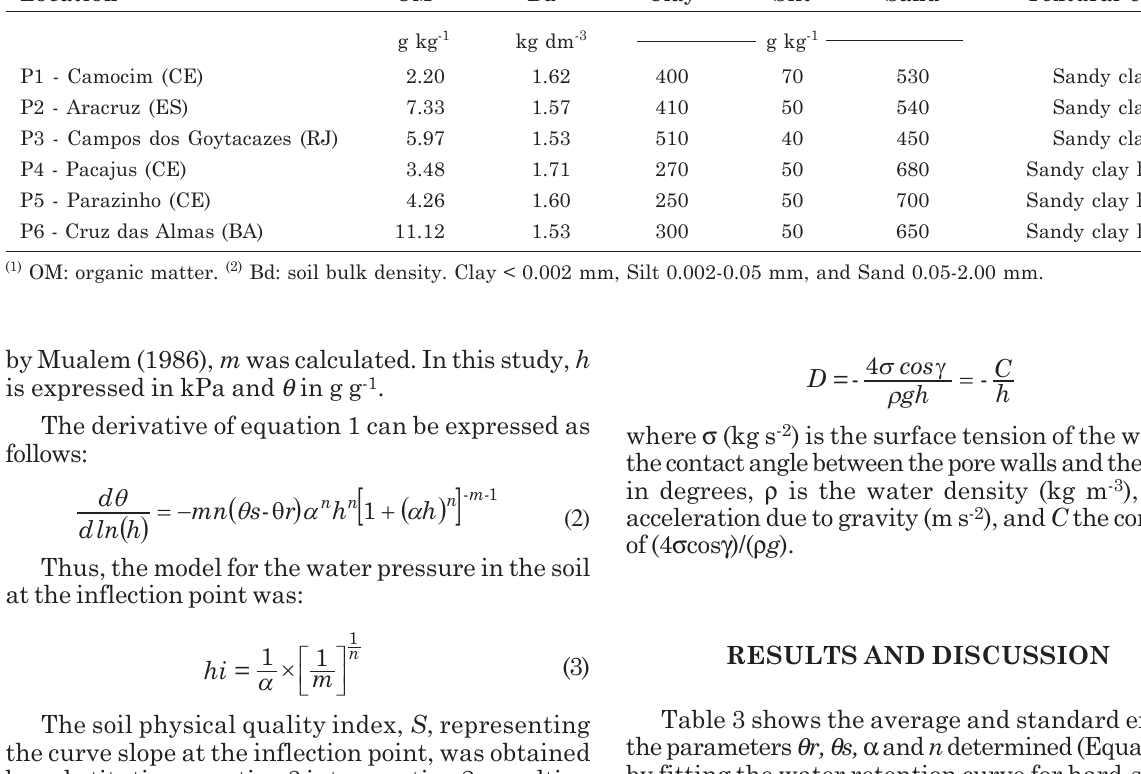
Table 2. Chemical properties and particle size distribution of hard-setting soils